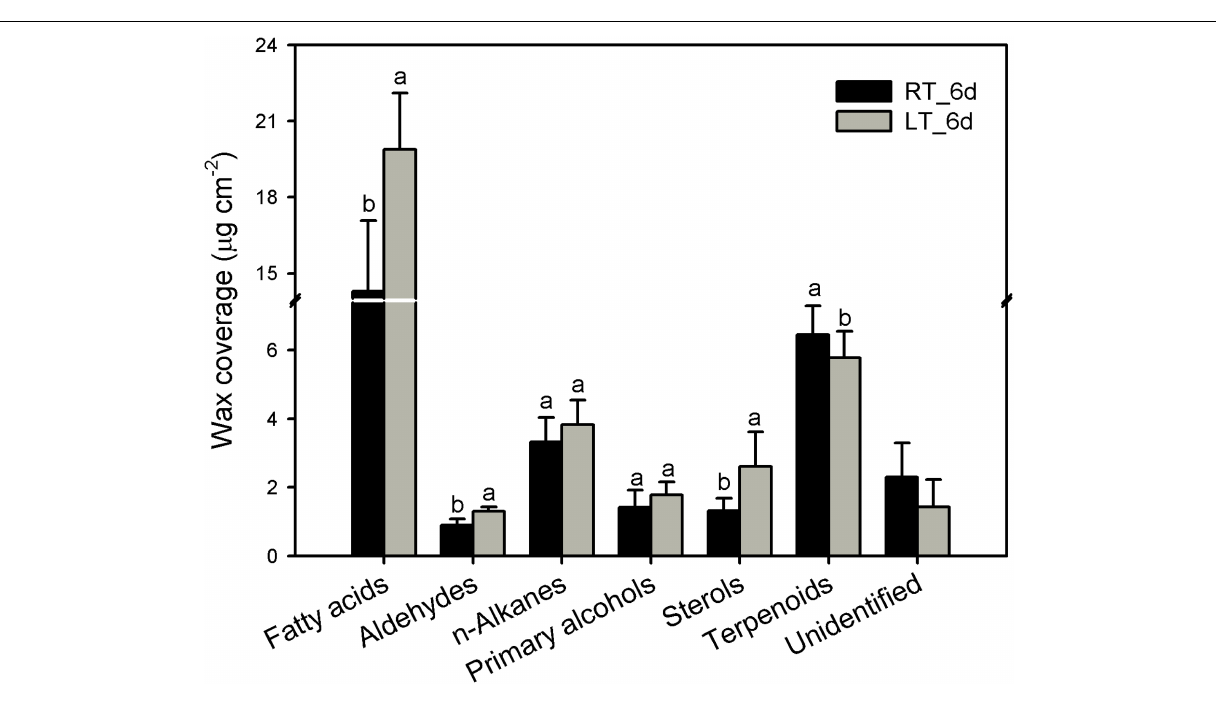
Frontiers in Plant Science |